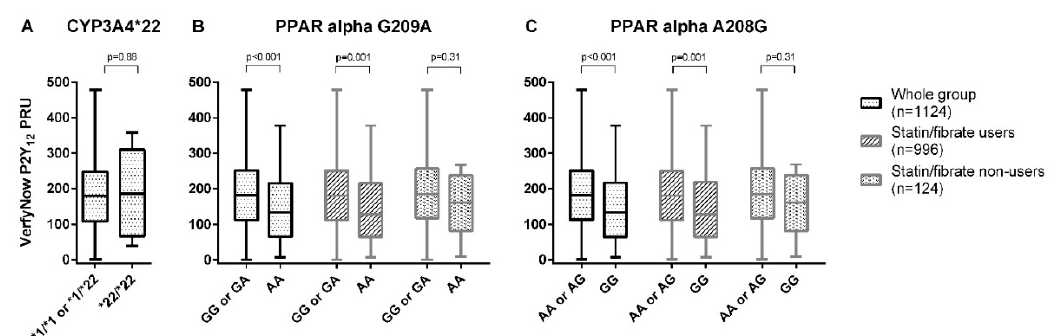
Figure 1. The on-treatment platelet reactivity, as measured with the VerifyNow ® P2Y 12 assay for CYP3A4 *22 ( A ), PPAR- α G209A ( B ), and PPAR- α A208G ( C ). Table 2. On-treatment platelet reactivity in carriers of recessive alleles of CYP3A4 *22, PPAR- α G209A, and PPAR- α